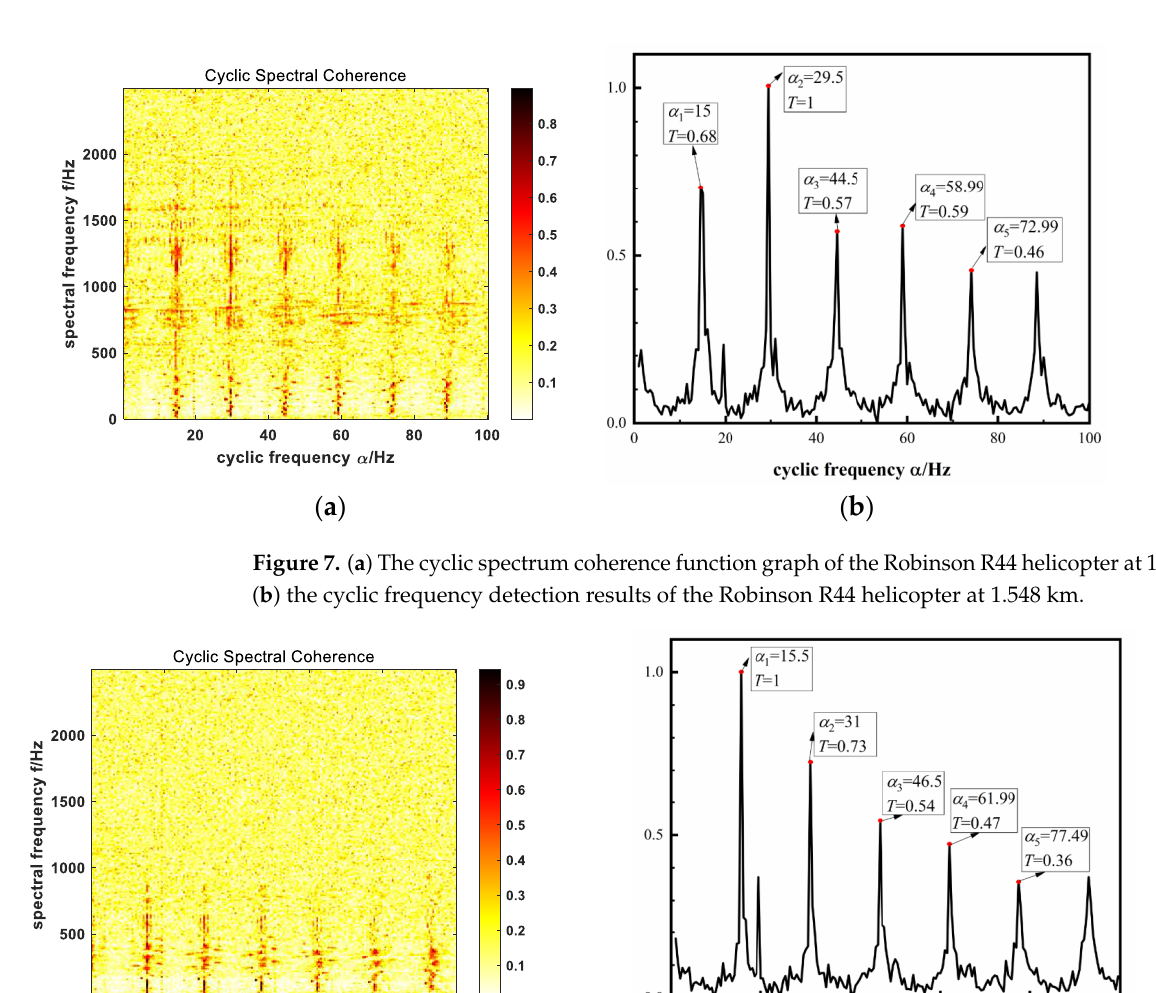
Figure 6. ( a ) The cyclic spectrum coherence function graph of the Robinson R44 helicopter at 0.89 km; ( b ) the cyclic frequency detection results of the Robinson R44 helicopter at 0.89 km. Then, the cyclic frequency detection was conducted at 1.548 km. Figure 7 presents